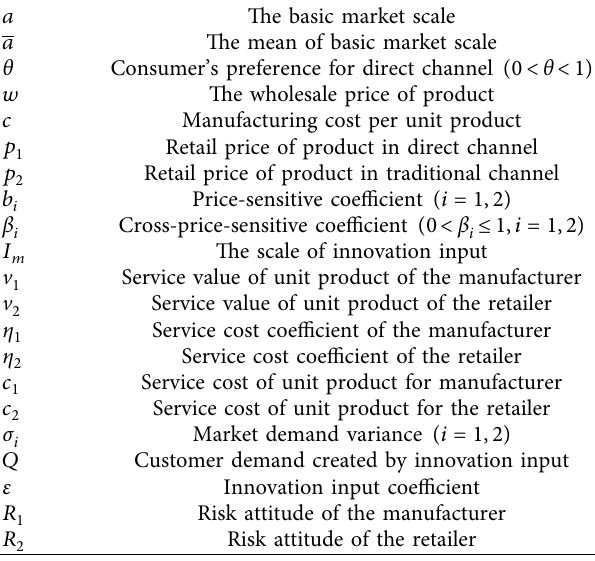
Figure 1: The dual-channel green supply chain system. Table 1: Notations and their